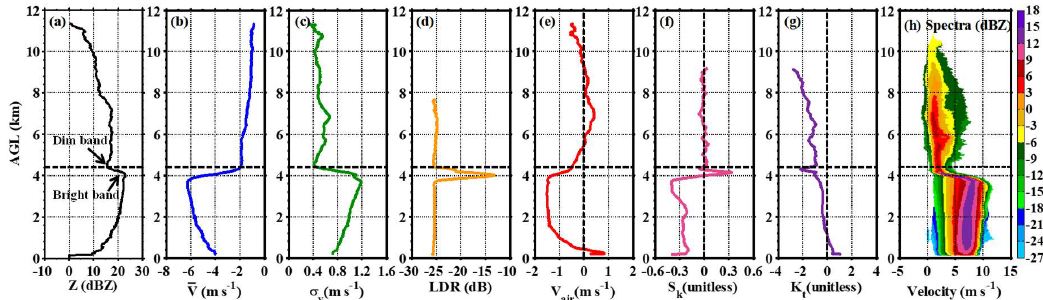
Figure 6. Profiles of the averaged radar measurements and mean Doppler spectra at different heights observed between 10:20–12:00 BJT on 21 April. ( a )–( h ) are reflectivity, mean Doppler velocity, spectrum width, linear depolarization ratio, vertical air velocity, spectral skewness, spectral kurtosis, and Doppler spectra.